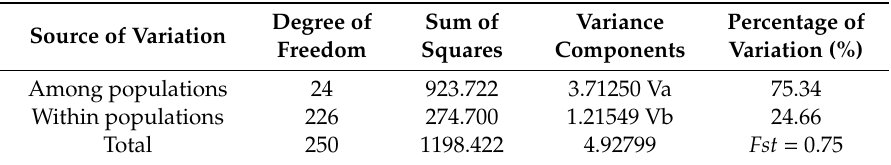
Table 3. Analysis of molecular variance (AMOVA) of cpDNA data of L. formosana populations.